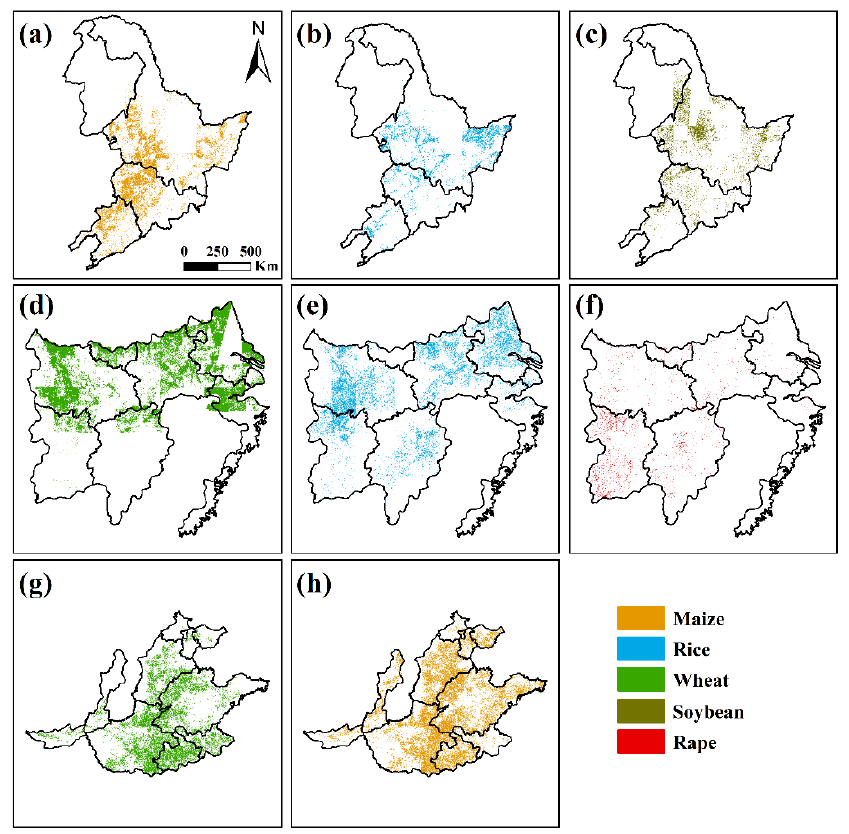
Figure 10. Spatial distribution maps of the major crops on the Northeast Plain ( a – c ), middle-lower Yangtze River plain ( d – f ), and North China Plain ( g – h ) during 2017 and